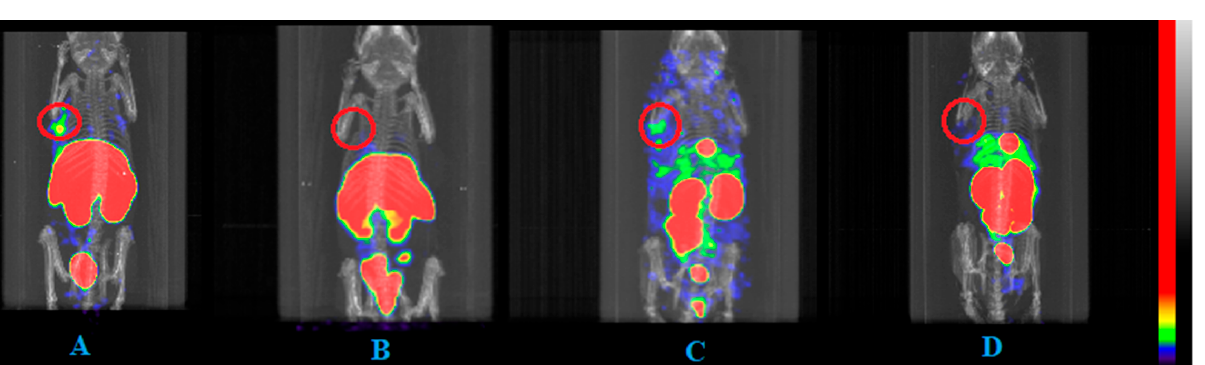
Figure 4. ( A ) Biodistribution of [ 99m Tc]Tc-CN5FA in KB tumor-bearing mice (* p < 0.05); ( B ) biodistribution of [ 99m Tc]Tc- CNPFA in KB tumor-bearing mice (** p < 0.01); ( C ) biodistribution of [ 99m Tc]Tc-CN5FA and [ 99m Tc]Tc-CNPFA in KB tumor- bearing mice at 2 h p.i.; ( D ) the ratios of tumor-to-nontargeted tissues of [ 99m Tc]Tc-CN5FA and [ 99m Tc]Tc-CNPFA.